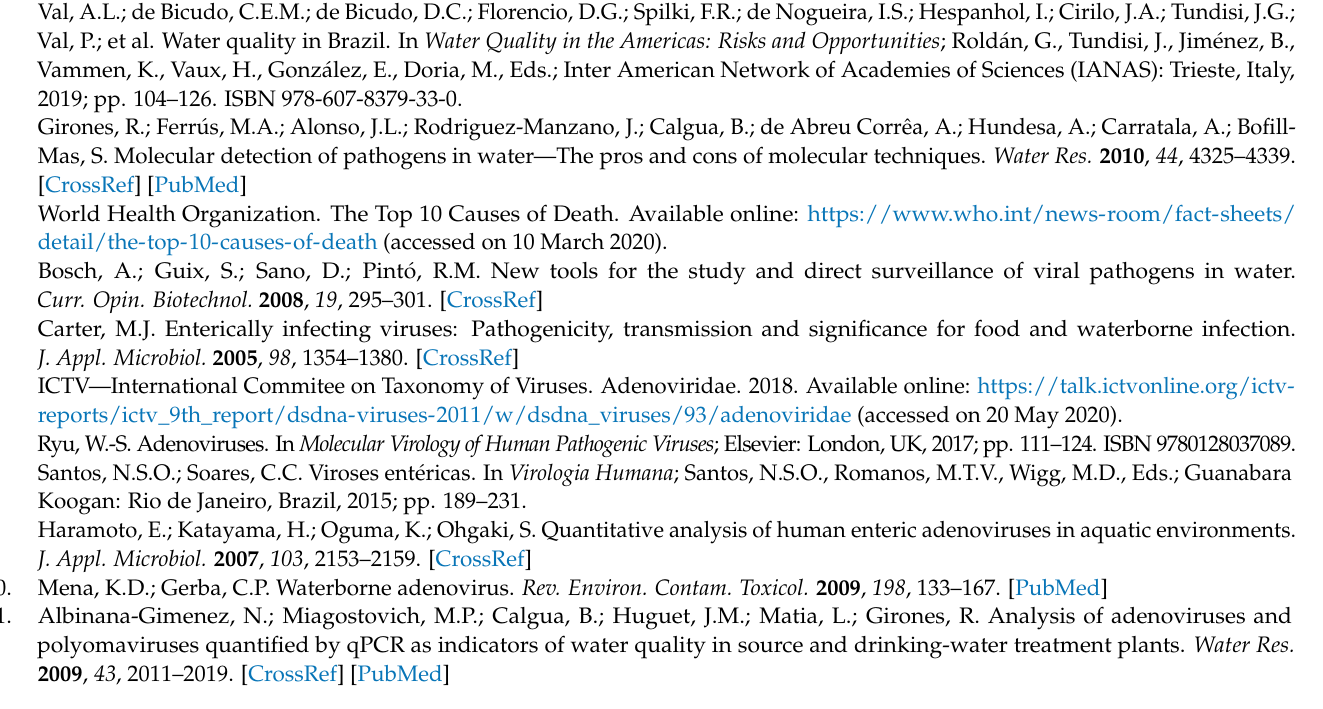
Figure S3: Nested PCR results in water samples that were carried out after IMS concentration